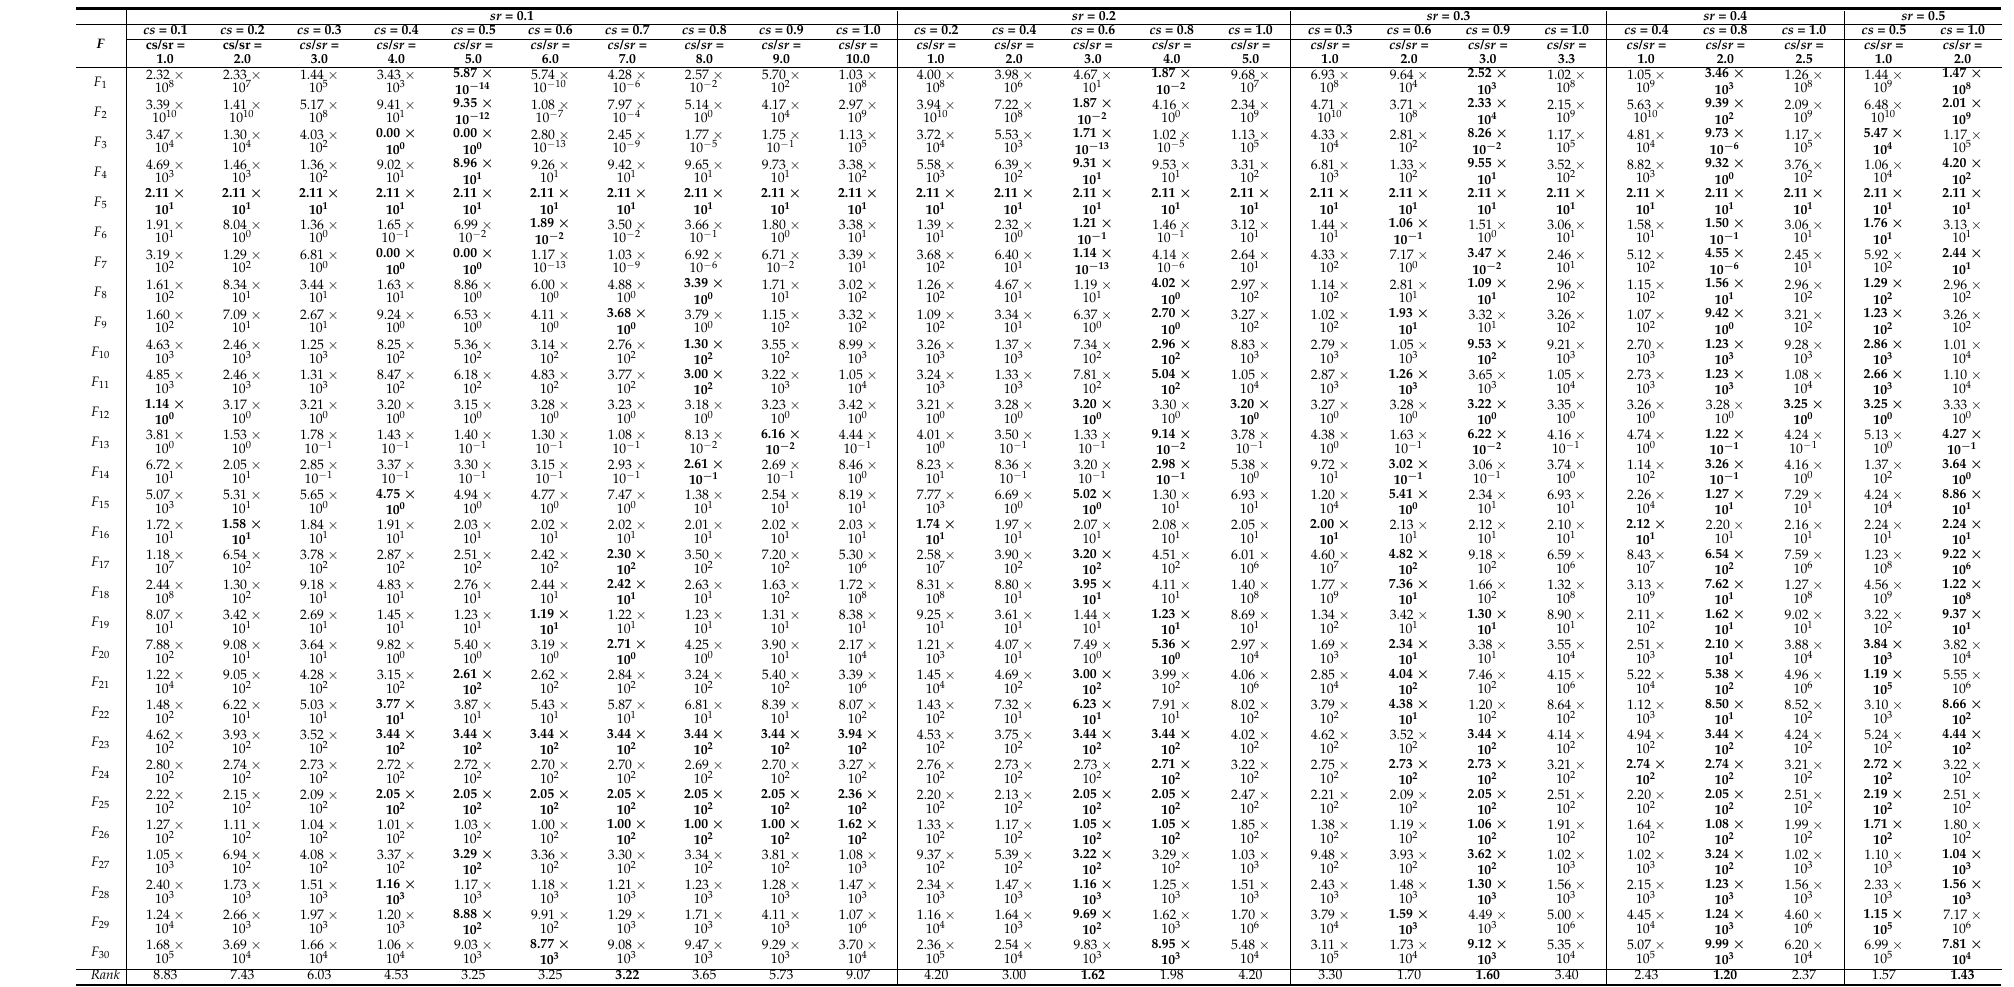
Table 5. Comparison among ACSEDA, with different settings of the selection ratio ( sr ) and different settings of the covariance scaling ( cs ) parameter, on the 50- D CEC 2014 benchmark problems. The best results in each part are highlighted in bold in this